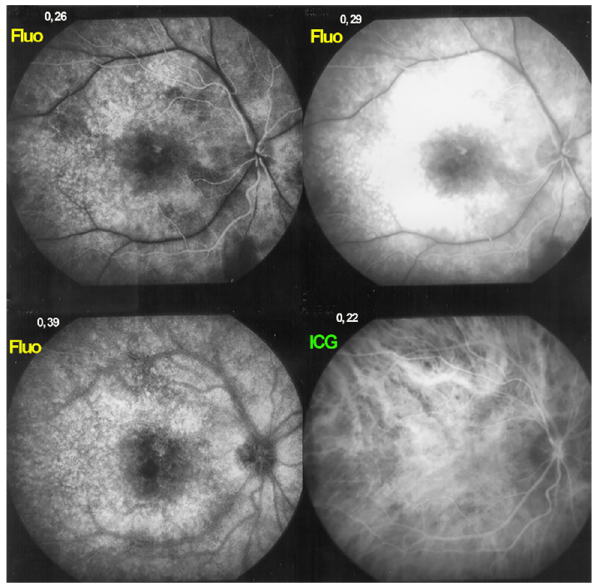
Figure 5. HLA-A29 birdshot retinochoroiditis, massive retinal exudation. There is such global retinal leakage (top right) that there is never fluorescein marking of the large veins (fluo pictures). This does however not correspond to arteriovenous perfusion delay, as the ICG frame already shows venous filling after 22 (cid:48)(cid:48) , meaning no delay.